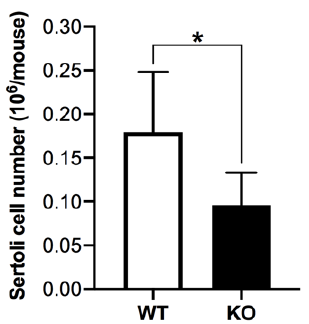
Figure 8. Lower yields of cultured Sertoli cells from 8-month-old Arsa KO mice, compared with those from age-matched WT mice. Sertoli cells were detached by Accutase treatment from the culture plate on culture day 7 and counted under a microscope. Results were from 4 replicate Sertoli cell isolations from the WT and KO animals. Four WT mice and 7-8 KO mice were used in each Sertoli cell isolation. * denotes p < 0.05.